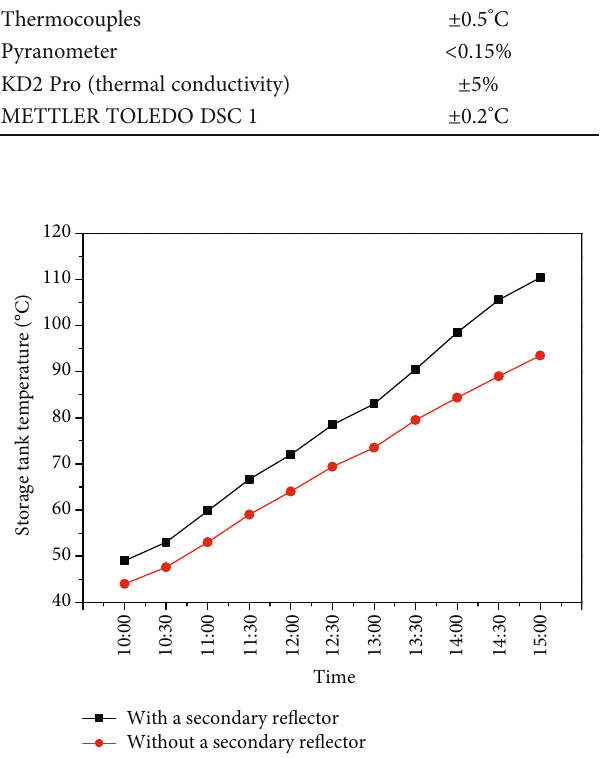
Figure 6: Variation of fl uid temperature with time.